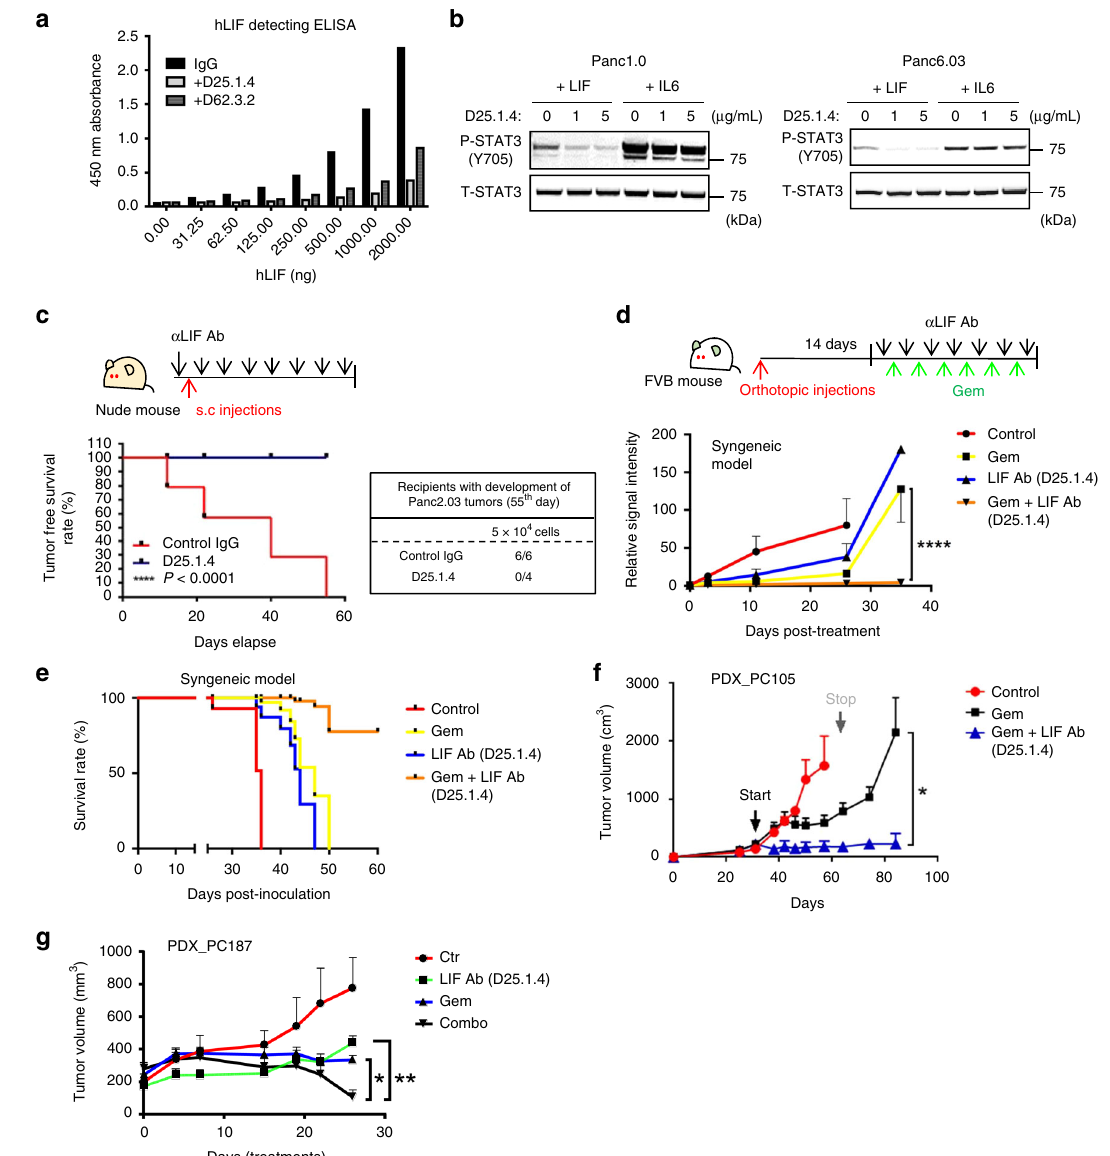
Fig. 4 LIF-neutralizing antibody acts as a therapeutic approach for treating KRAS-driven pancreatic cancers. a Representative ELISA assay showing that LIF antibodies (D25.1.4 and D62.3.2) prevent recombinant human LIF from binding to microplate pre-coated with human LIF monoclonal antibody (Invitrogen BMS242). b Representative western blots suggesting that use of a LIF-neutralizing antibody blocks the STAT3 activation/phosphorylation induced by recombinant human LIF (50 ng/mL) in human pancreatic cancer cell lines, whereas IL-6 induces STAT3 activation. c Tumor free survival rate and numbers of palpable tumors in Panc2.03 xenografts model receiving control or LIF antibody at 10 mg/kg. ( d ) Tumor growth in syngeneic mouse model